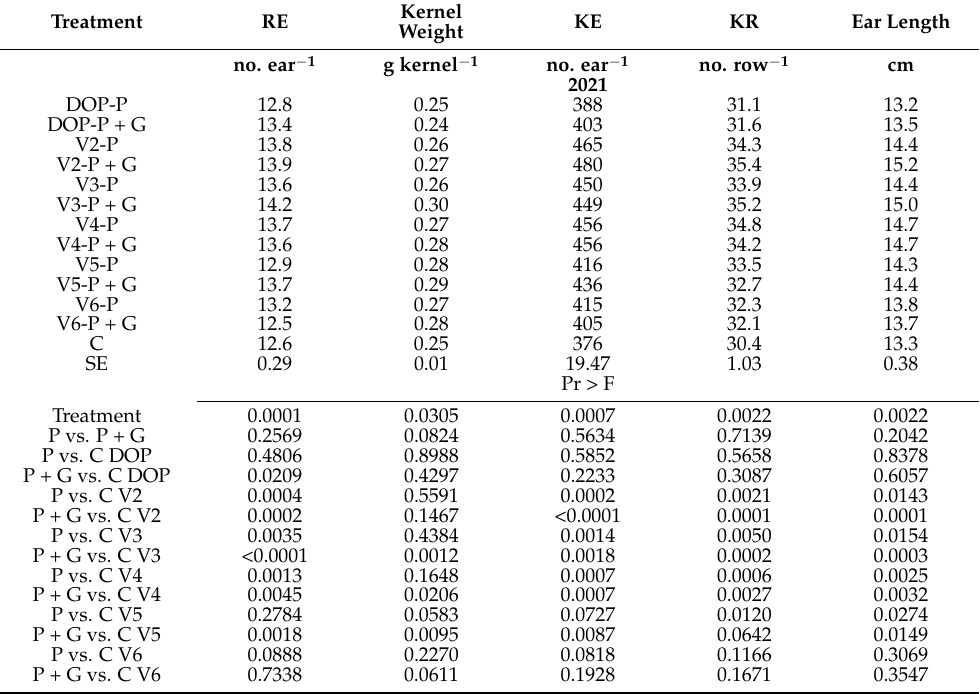
Table A2. Treatment means and significance for maize yield components of rows per ear (RE), kernel weight, kernels per ear (KE), kernels per row (KR), and ear length at Sorenson Research Farm in